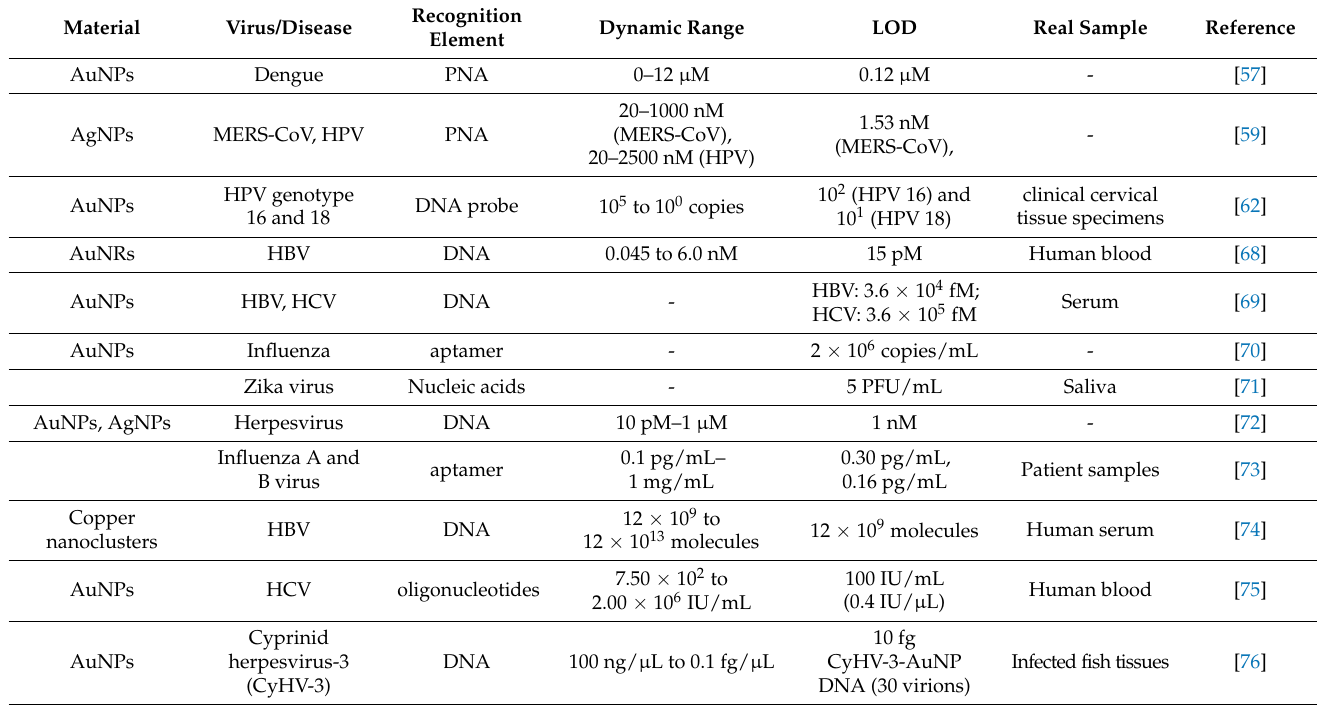
Table 1. List of the colorimetric biosensors for virus